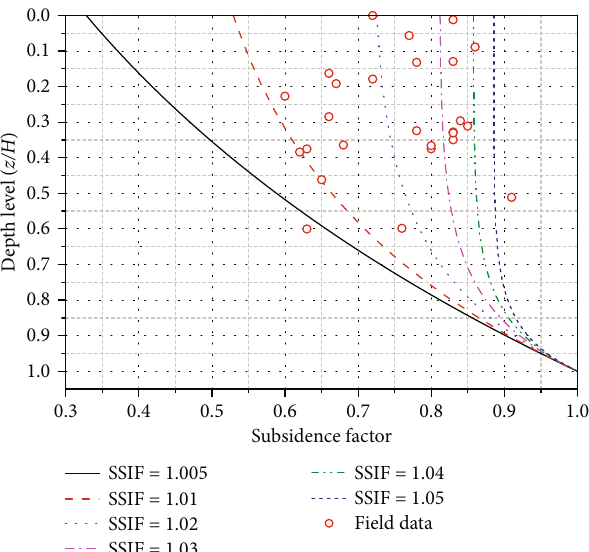
Figure 4: Curves of the subsurface subsidence factor with di ff erent